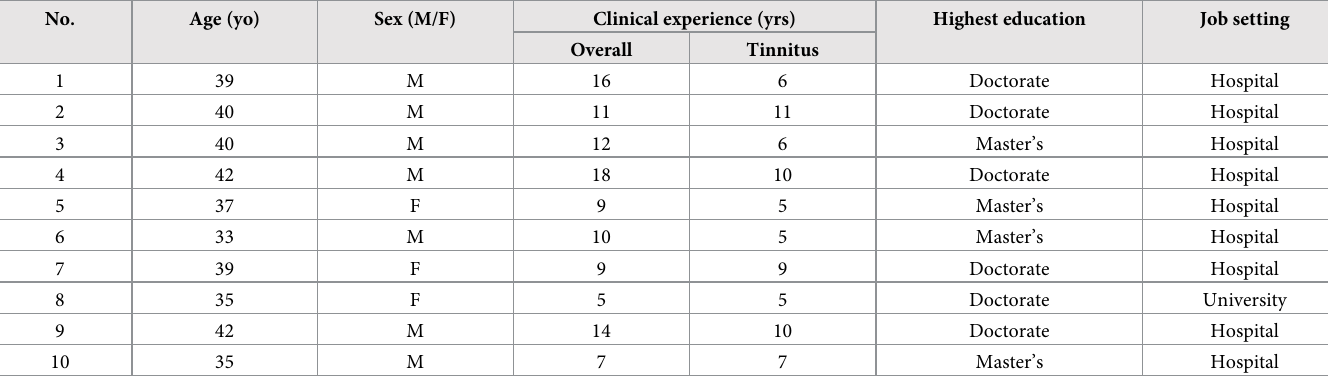
Table 1. Demographics of the healthcare professionals (n =